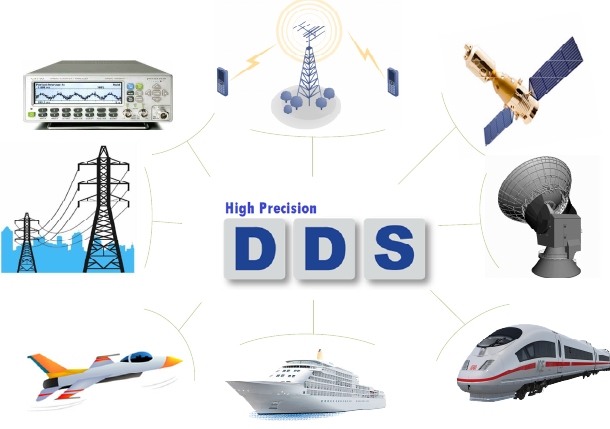
Figure 1. Applications of high precision DDS.